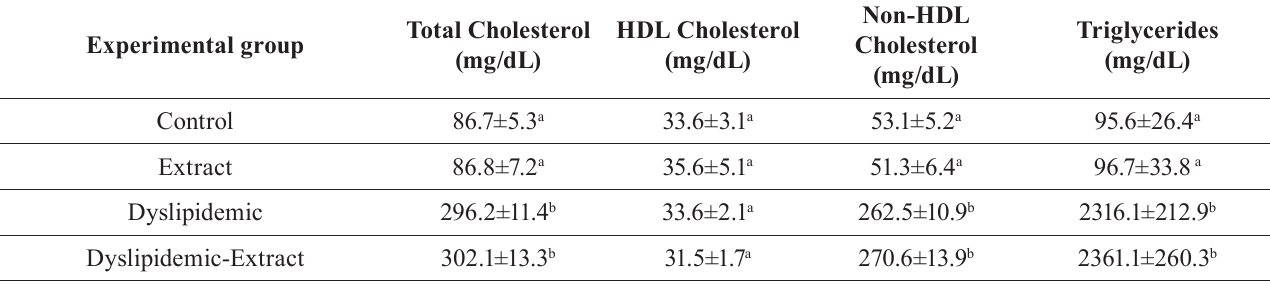
The values represent the average ± standard deviation of eight measurements per treatment. Averages followed by the same letter in the same column do not differ statistically. Different letters (a, b) in same column indicate statistical significance by Scott-Knott Test ( p < 0.05). HDL: high-density lipoprotein.